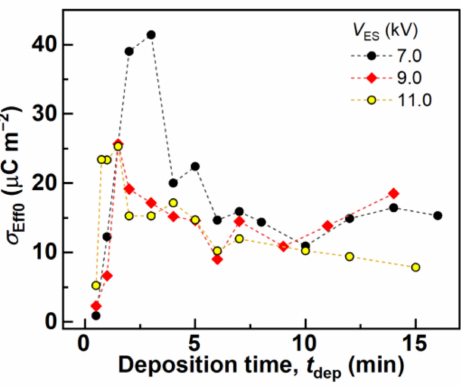
Figure 8. Calculated σ Eff0 of the fiber mats produced with different t dep and V ES